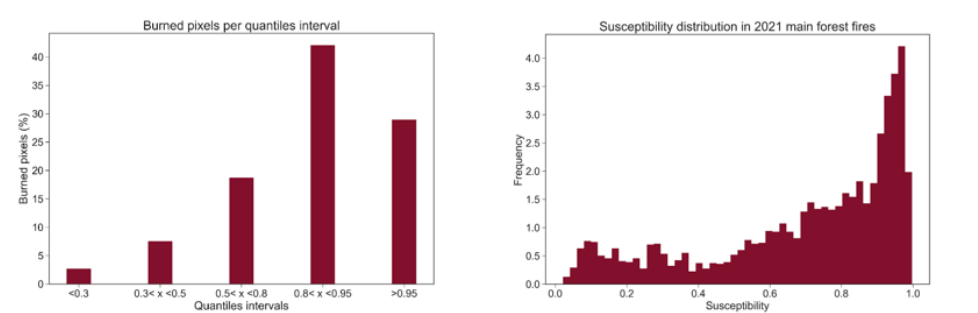
Figure 18. On the left, the 2021 burned area pixel distribution grouped by the five percentile classes (defined by the values of the following percentiles: 30, 50, 80, 95). On the right, the continuous distribution of the susceptibility inside the burned area related to the 2021 wildfires.